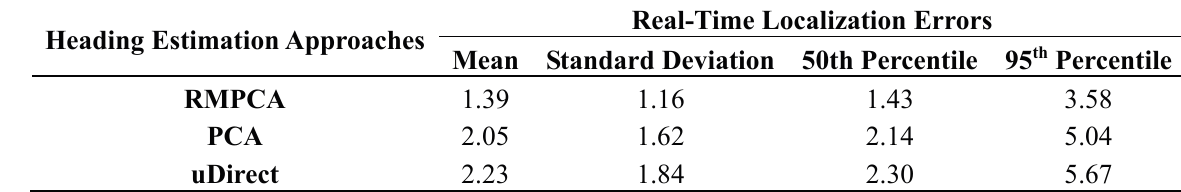
Figure 11. Tracking performance comparisons of one trace between different heading estimation approaches. Table 1. Comparisons of real-time localization errors